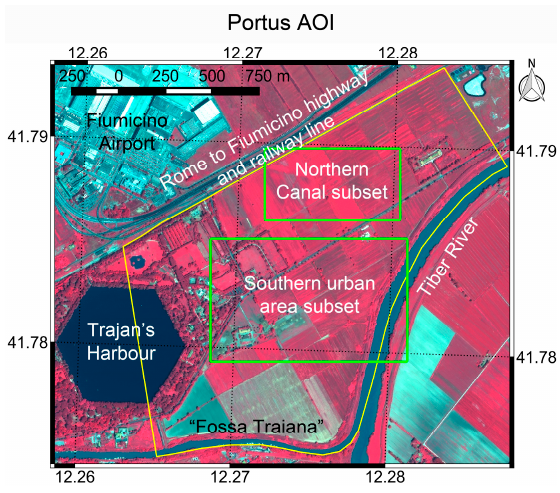
Figure 8. Portus AOI shown as yellow polygon on Pleiades image acquired on 8 May 2014. The Northern Canal and southern urban area subsets are shown by the green rectangles. The image was pan-sharpened to 0.5 m spatial resolution, and is displayed as NIR, R and G respectively as R, G and B. Pleiades data provided by the European Space Agency.